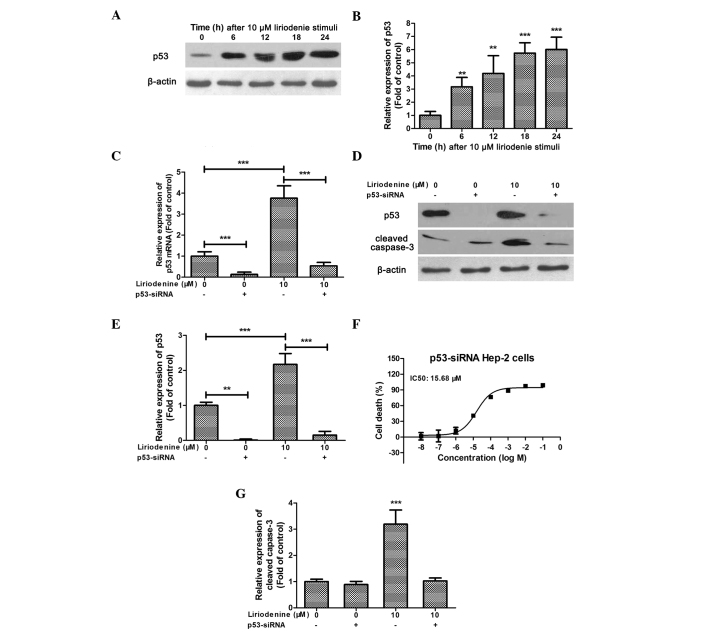
Downregulation of p53 expression suppresses the pro-apoptotic effect of liriodenine. (A) Western blot analysis revealing the expression of p53 at different times following treatment with 10 μM liriodenine. β-actin was used as the internal control. Blots were repeated at least three times for statistical analysis. (B) Statistical analysis of p53 expression at different times following treatment with 10 μm liriodenine. **P<0.01 and ***P<0.001 compared with the vehicle-treated group (n=3). (C) Expression of p53 mRNA, following treatment with liriodenine in the presence or absence of p53-small interfering RNA (siRNA), was determined by quantitative polymerase chain reaction. ***P<0.001 compared with the vehicle-treated group (n=3). (D) Western blot analysis revealing the expression of p53 and cleaved caspase-3 following treatment with liriodenine. β-actin was used as the internal control. Blots were repeated at least three times for statistical analysis. Statistical analysis of (E) p53 and (F) cleaved caspase-3 expression following treatment with liriodenine, in the presence or absence of p53-siRNA. **P<0.01 and ***P<0.001 compared with the vehicle-treated group. (G) The effect of liriodenine upon the cellular viability of p53-siRNA-infected HEp-2 cells was determined by MTT assay.